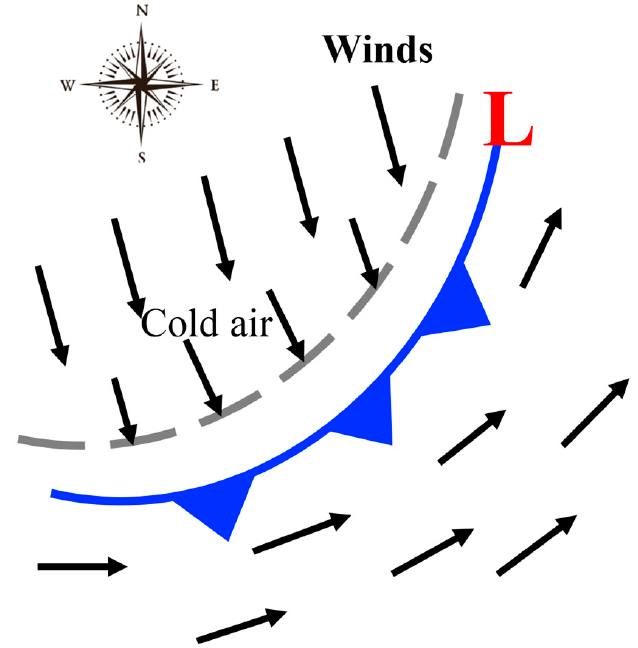
Figure 4. Schematic figure of the cold front system and the wind shift at a cold front.